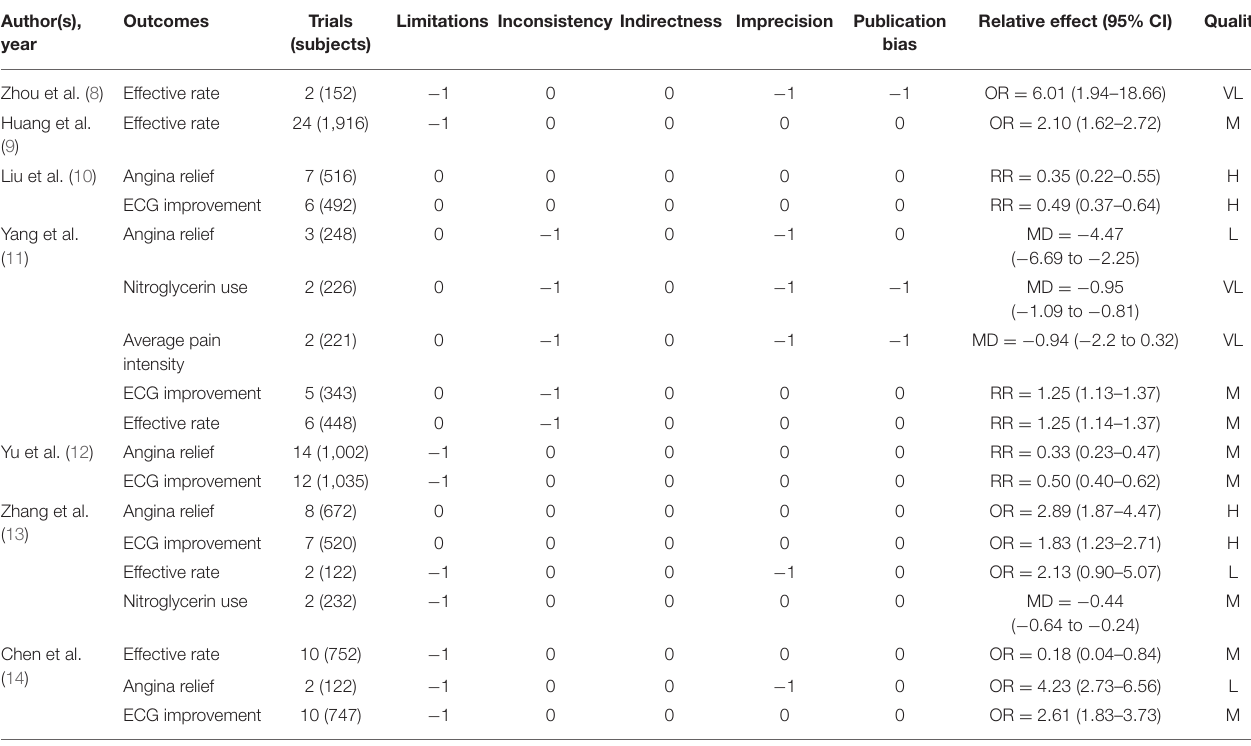
TABLE 5 | Results of GRADE